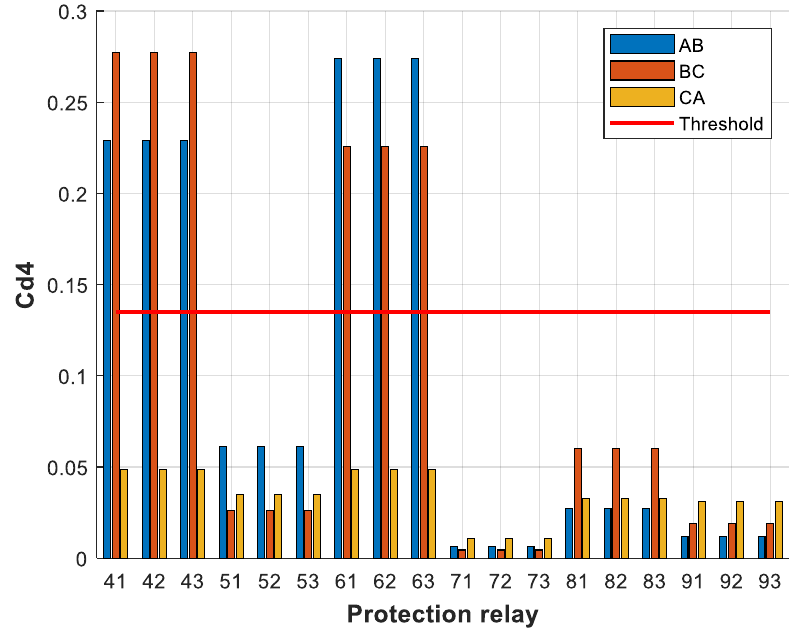
Figure 9. Differences in voltage Cd4-dB3 on the transmission line from bus 4 to bus 6.